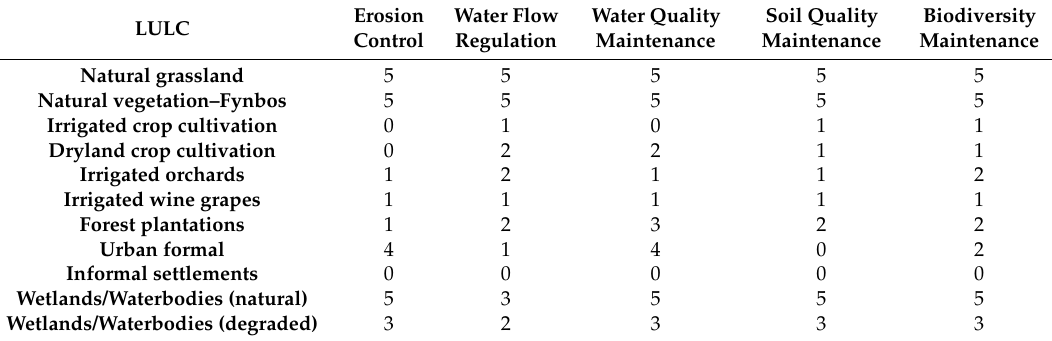
Table 2. Assigned values of LULC classes and ecosystem service (5 = the highest capacity and 0 = no